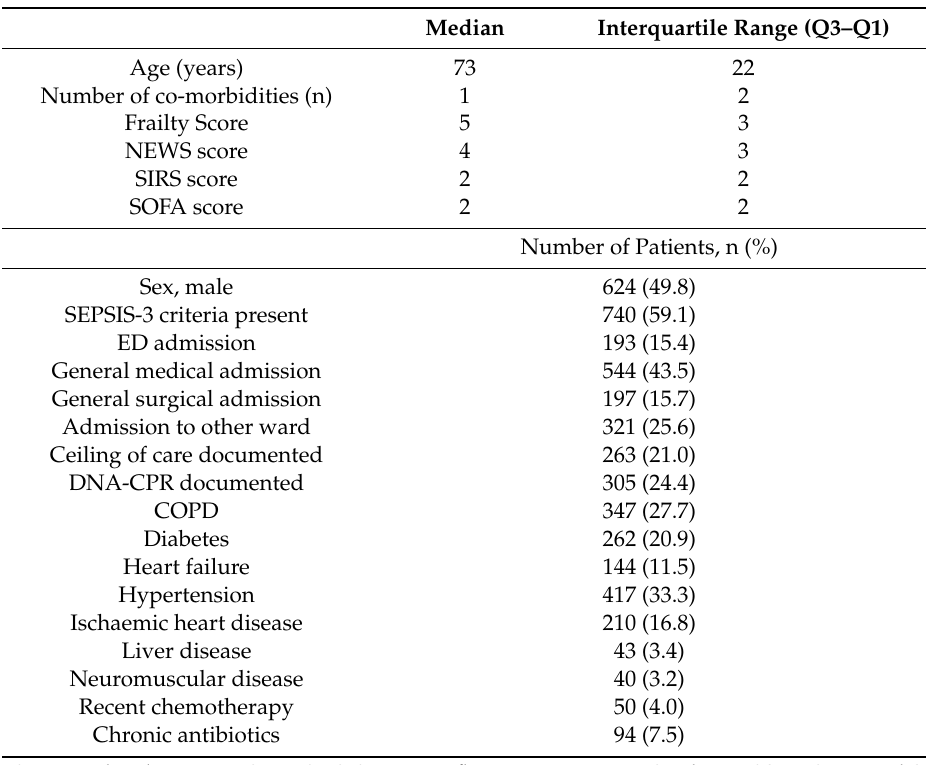
Table 1. Patient demographics